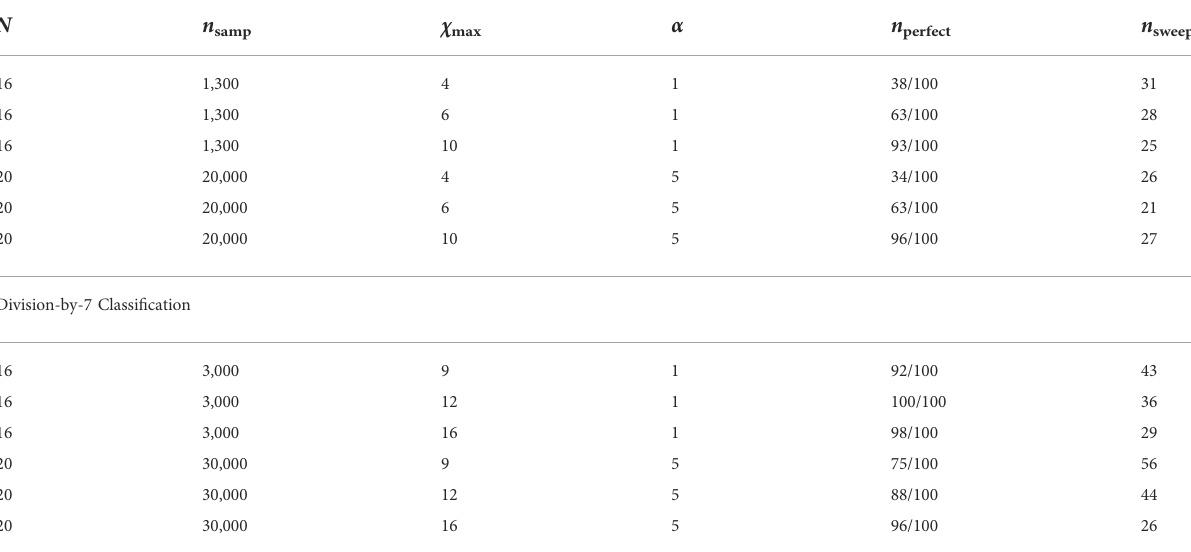
TABLE1SummaryofresultsforMPSappliedtotheparityclassi fi cation(above)anddivision-by-7classi fi cation(below).Parametersareasfollows: N is the length of binary strings classi fi ed, n samp is the number of samples in the training set, χ max is the maximal MPS bond dimension, parameter α controls the randomness in the optimization as per Eq. 14, n perfect is the proportion of trial runs that yielded perfect (100% accuracy) classi fi ers, n sweeps is the average number of variational sweeps required to reach convergence.